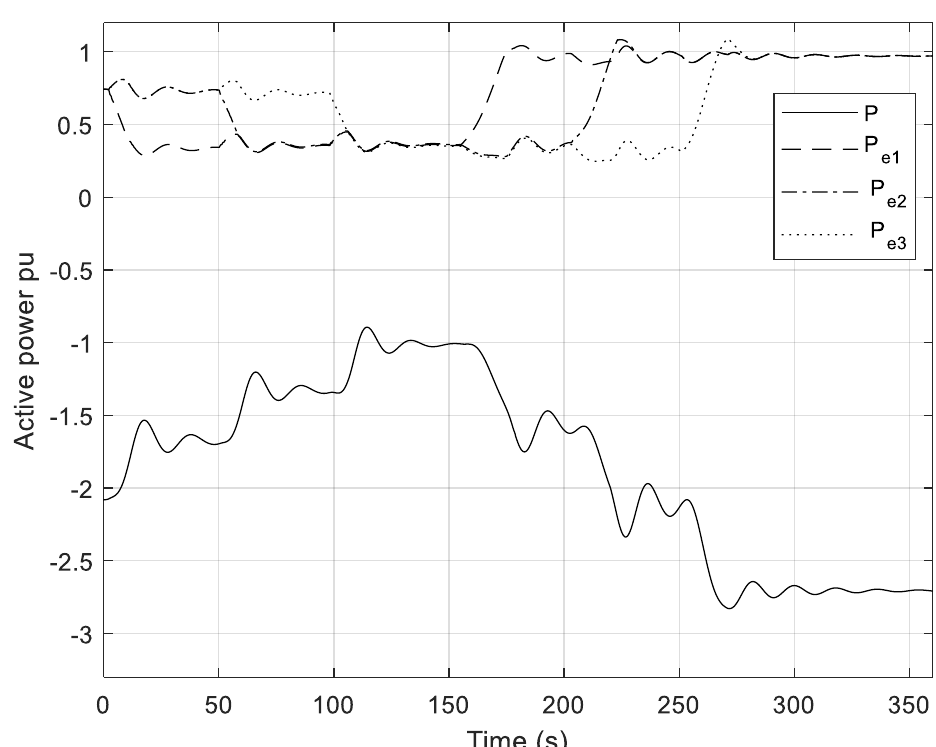
Figure 16. Active power of B2B converter and active power of the PMSGs.